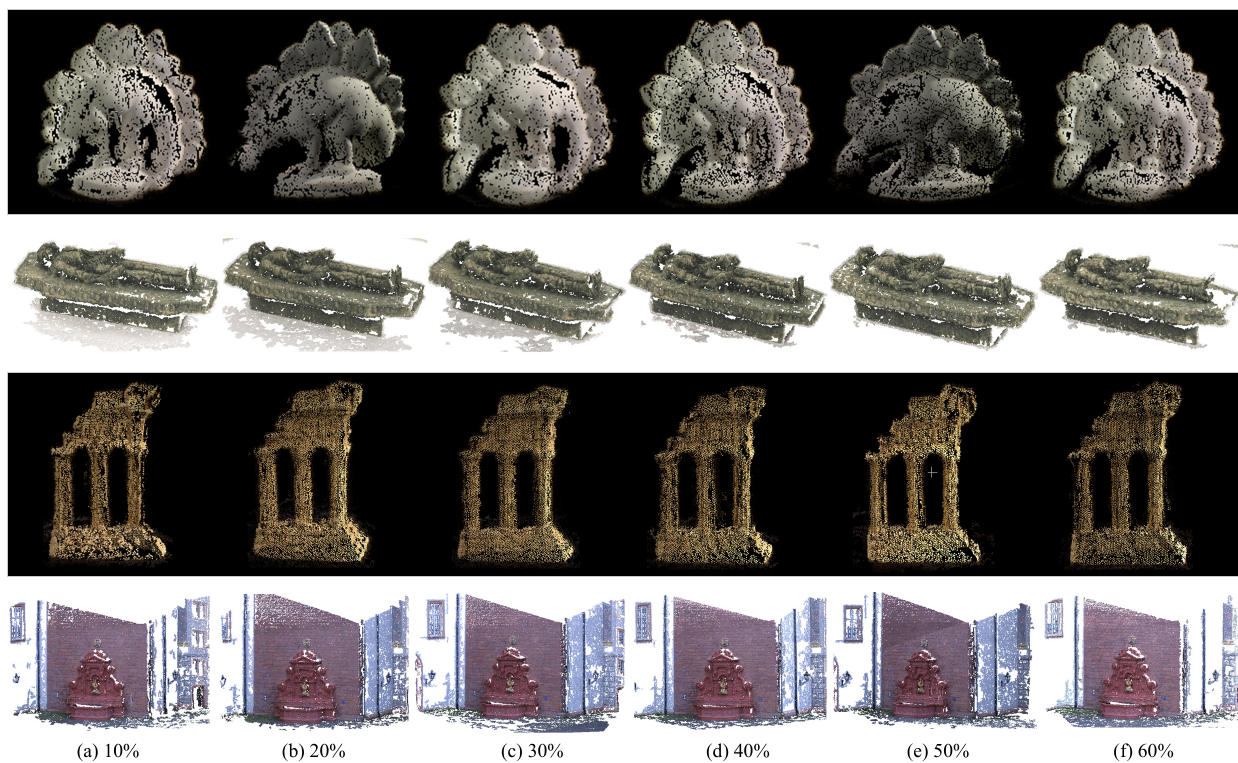
Figure 7. The reconstructing models of proposed method under different illumination variations of input images. The con- trolling factor τ varies from 10% to 60% (from left to right) and the reconstructed point cloud models are illustrated. Top to bottom: “Dino16”, “Mummy24”, “Temple47”, “Foundation25”.